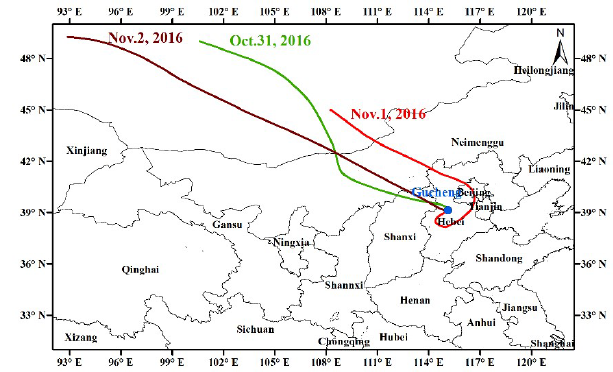
Figure 5. The 48h back trajectories at 500m at the GC site (39 ◦ 09 (cid:48) N, 115 ◦ 44 (cid:48) E) at 00:00UTC from 31 October to 2 Novem- ber 2016.